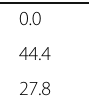
Table 5 EORTC QLQ-C30 and supplemental items: Item-level endorsement frequencies ( n = 18) from Stage 2